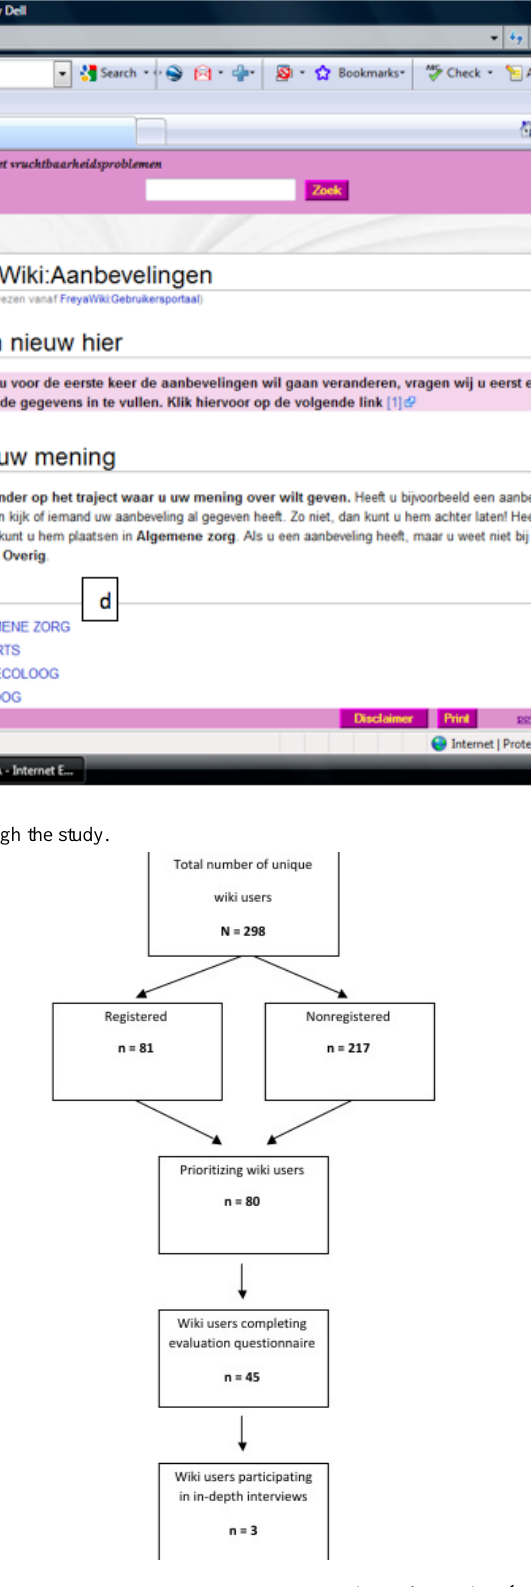
Figure 3. Screenshot of the FreyaWIKI homepage.